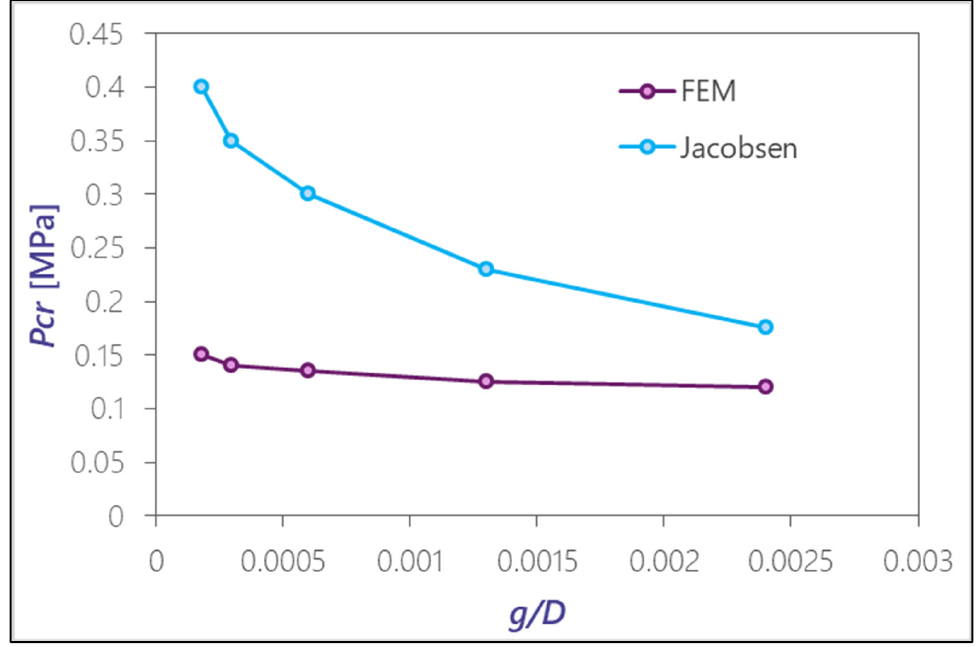
Figure 15. Comparison between Jacobsen and FEM results for a range of ratios g / D